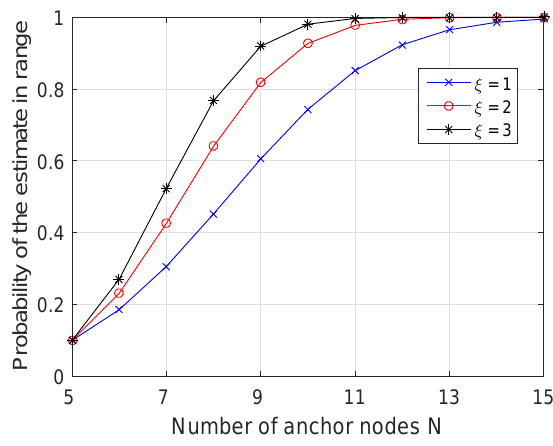
Figure 8. GDoP versus number of anchor nodes N